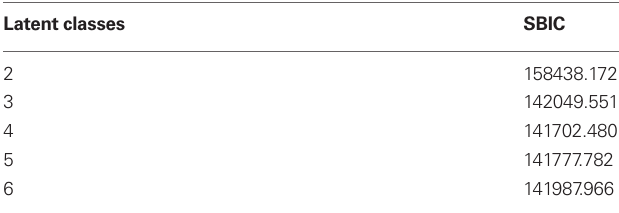
Table 3 | Size adjusted BIC values for 2, 3, 4, 5, and 6 latent